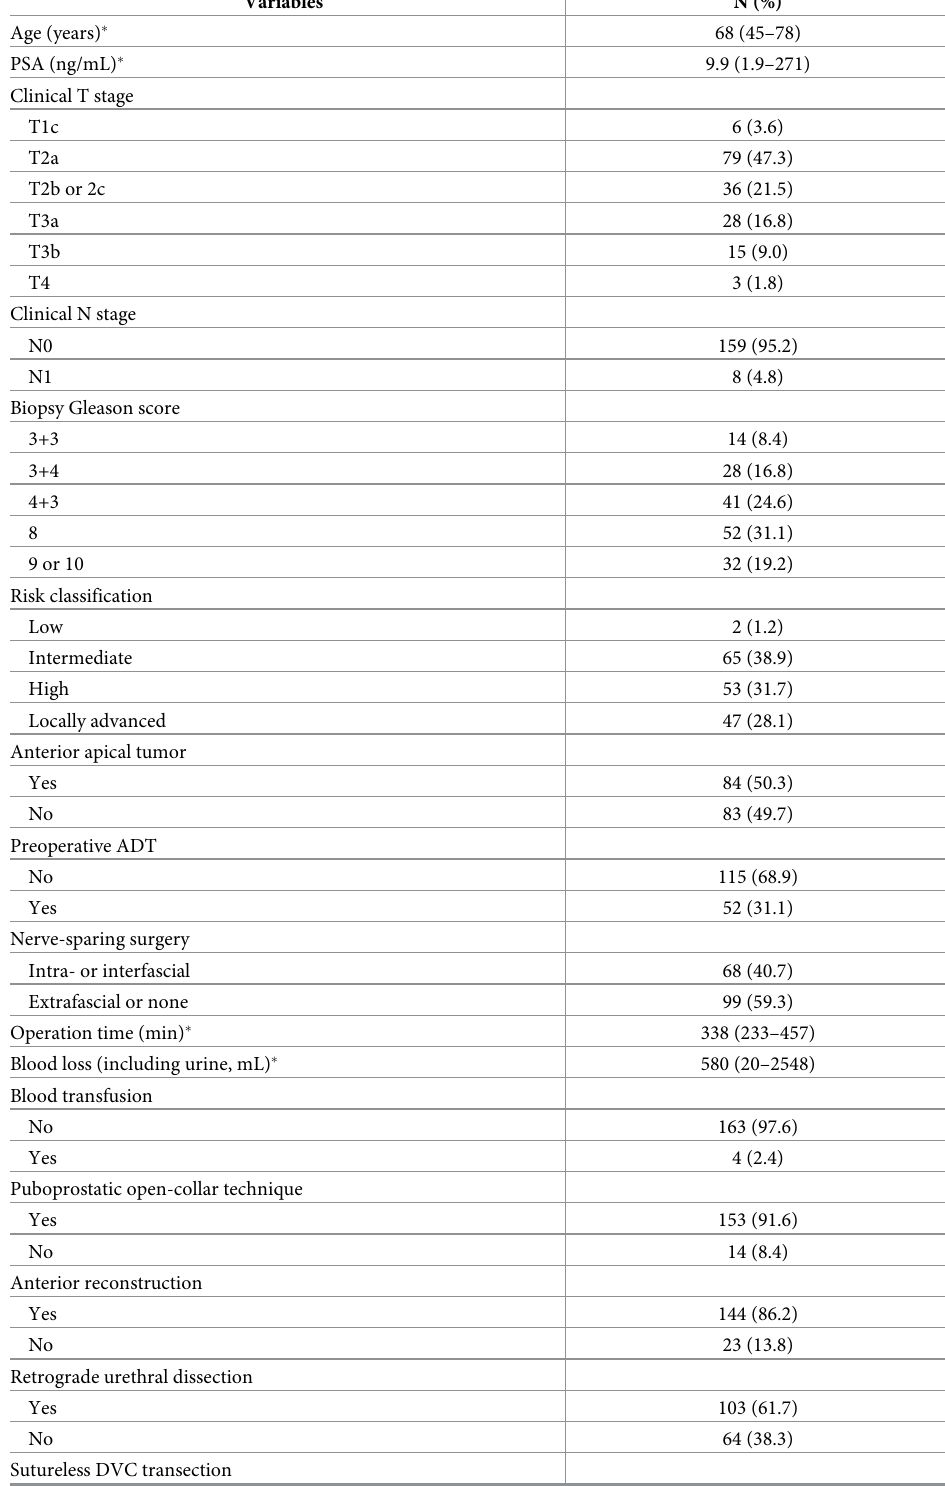
Table 1. Demographics of 167 men undergoing